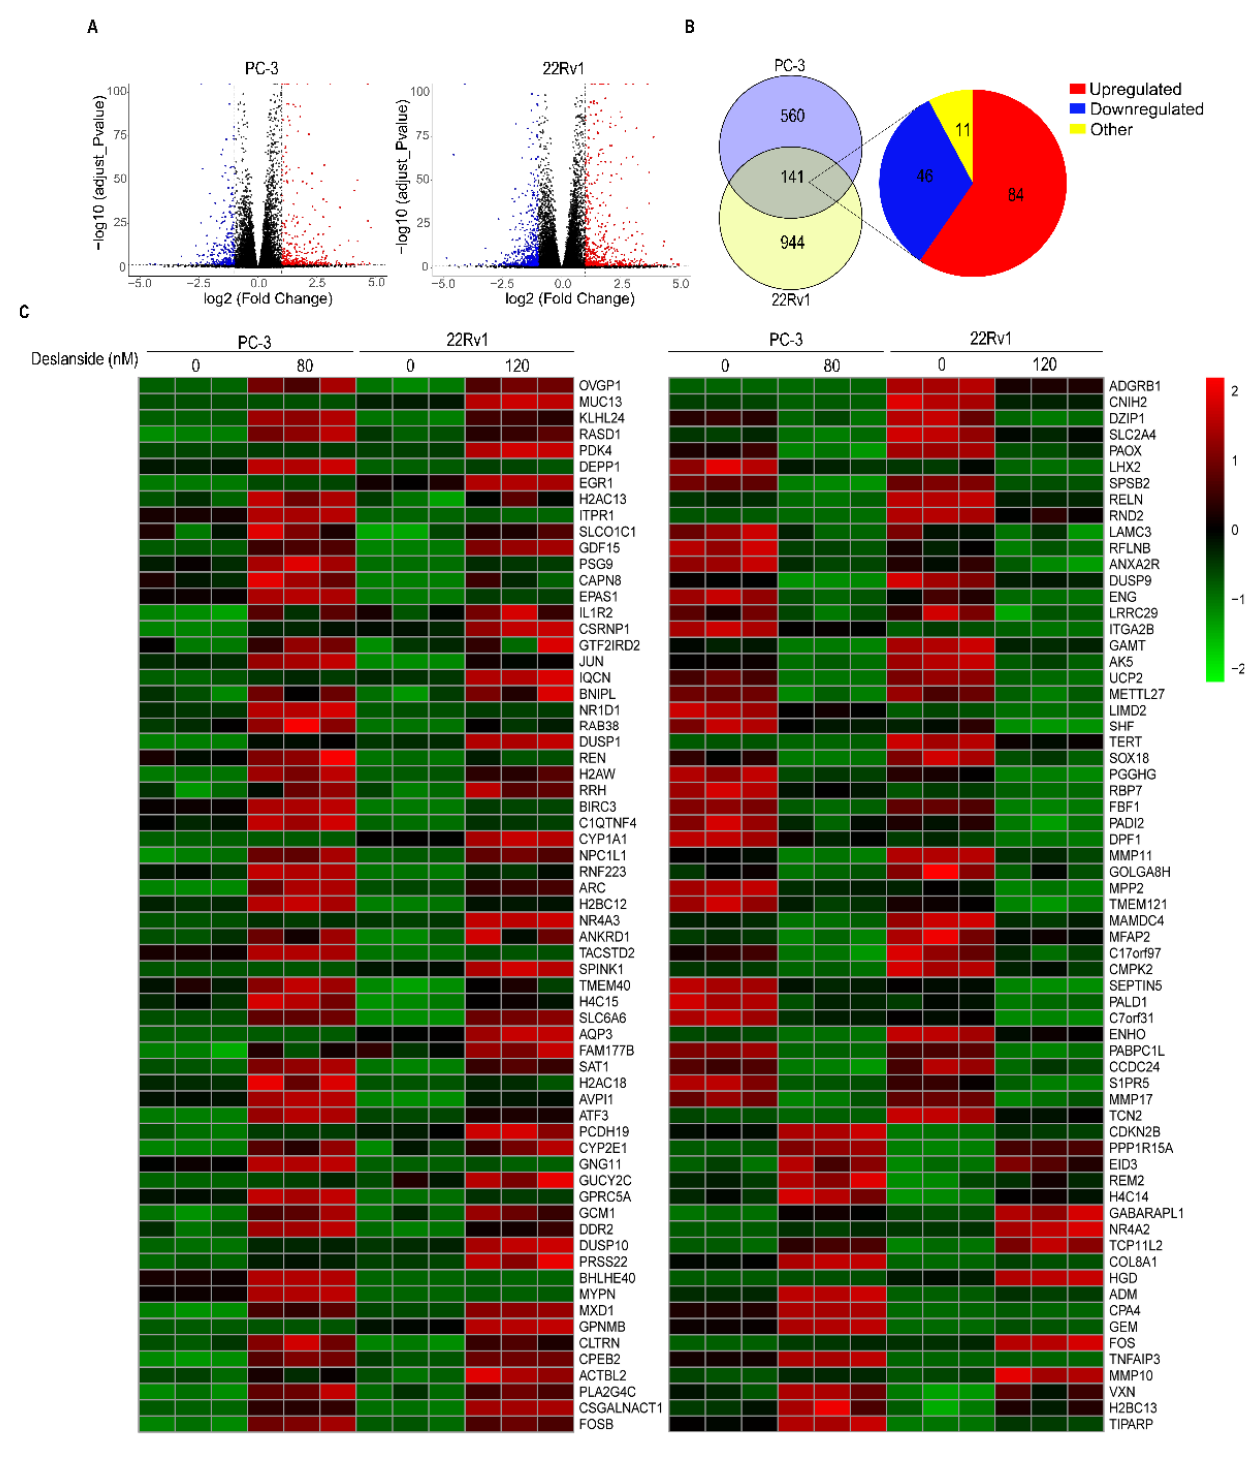
Figure 5. Effect of deslanoside on global gene expression in 22Rv1 and PC-3 PCa cells. ( A ) Volcano plots of all quantified genes from the gene expression profiles between the control and deslanoside-treated groups in 22Rv1 and PC-3 PCa cell lines. ( B ) Venn diagram showing deslanoside-induced differentially expressed genes (DEGs) in 22Rv1 cells (560, purple), PC-3 cells (944, light yellow), and overlapped DEGs between 22Rv1 and PC-3 (141, gray). Red and blue indicate genes that were upregulated (84) and downregulated (46), respectively, in both cell lines. Yellow indicates genes (11) that were upregulated in one cell line but downregulated in the other. ( C ). Heatmap of the 130 DEGs regulated by deslanoside in PC3 and 22Rv1